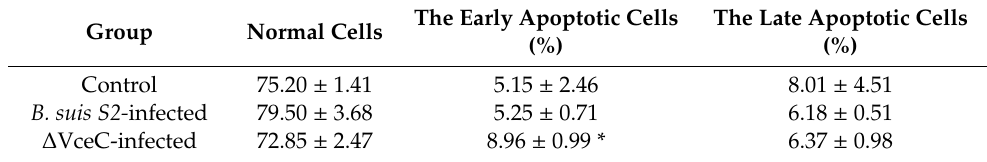
Table 2. Results of Annexin V-FITC / PI staining for cell apoptosis after B. suis S2 and ∆ VceC infection at 48 h.